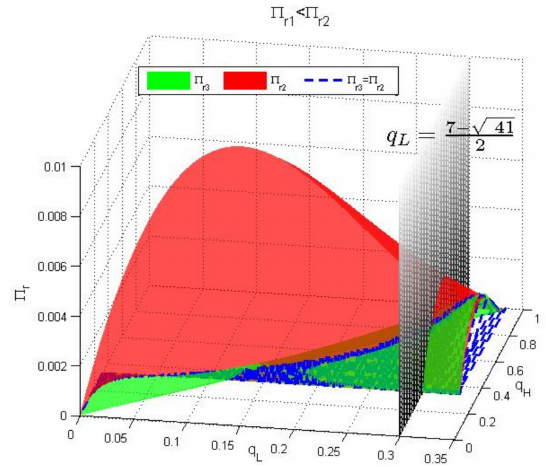
Figure 3. Π r 2 versus Π r 3 when q H (1 − q H ) 2 > q L (1 − q L ) 2 .